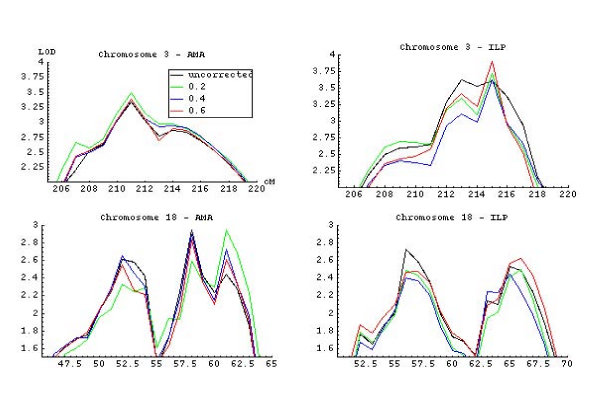
LOD scores obtained using MIBDs uncorrected and corrected for LD. These are plots of the maximum LOD score region of chromosomes 3 and 18 of the COGA ttdt3 trait. LOD scores were calculated using MIBDs constructed by removing SNP pairs that in founders showed LD as r2 ≥ {0.2, 0.4, 0.6}. LOD scores calculated using uncorrected MIBDs are also shown.